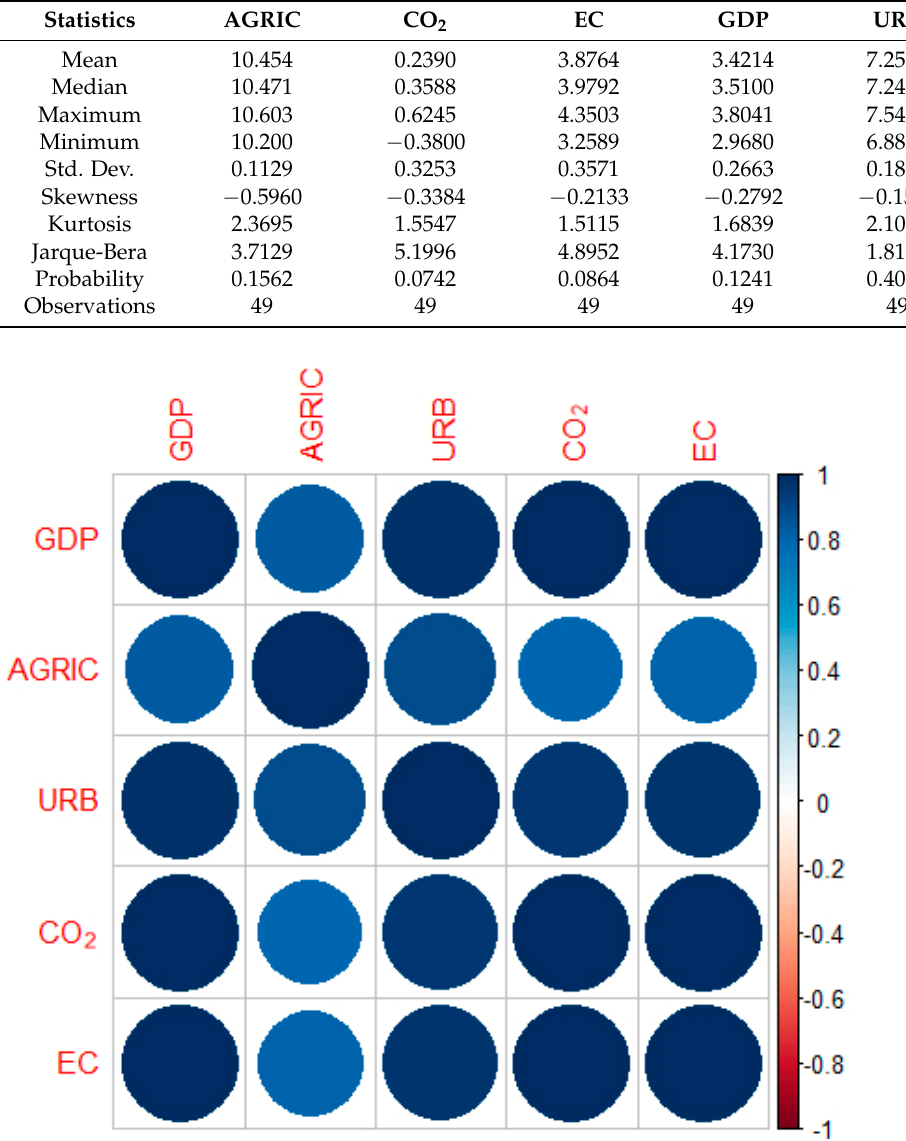
Figure 1. Correlation